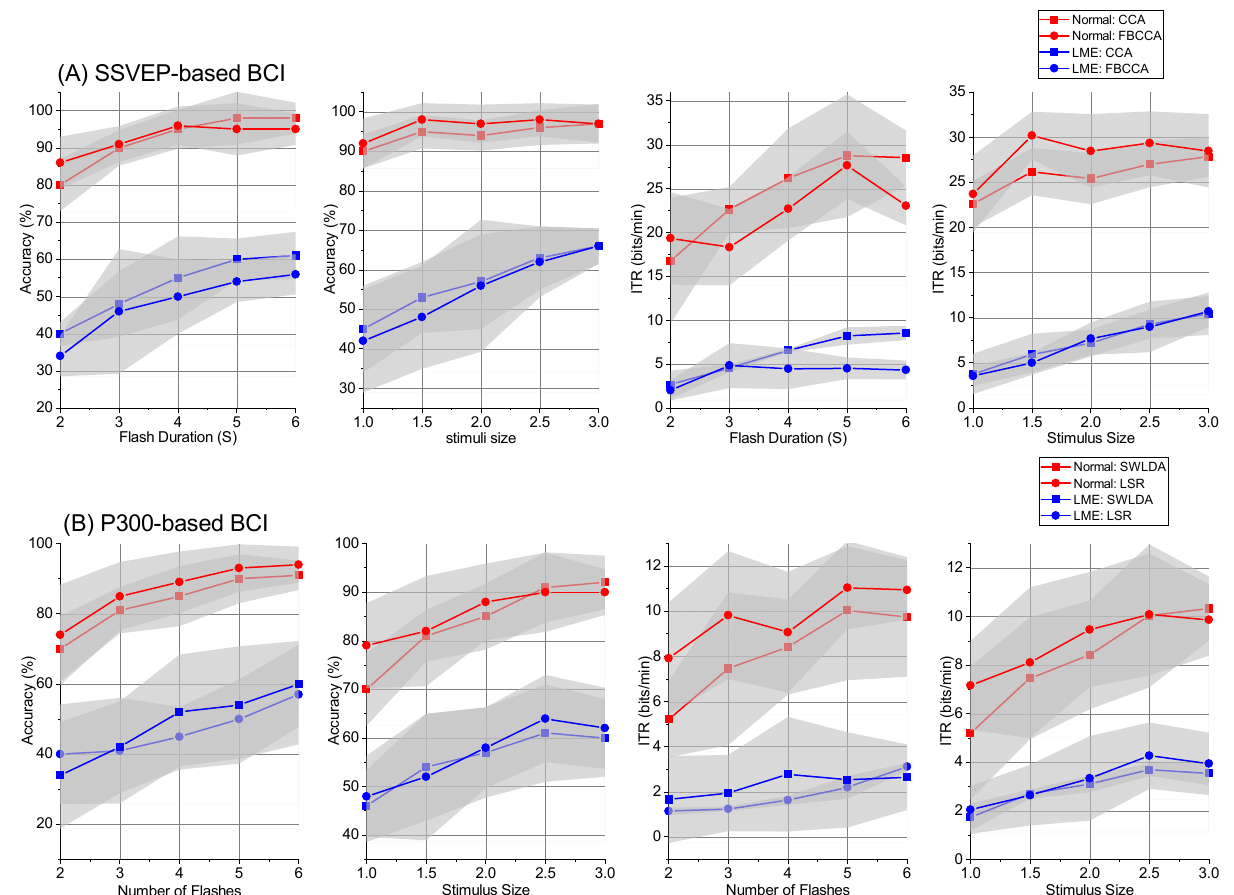
Figure 7. Effects of the flash number, flash duration, and stimulus size on BCI performance. The shaded areas in this figure represent the error bands. We plotted this figure using the EEG signals collected in the optimization phase of the normal and LME condition experiments. The subfigures ( A , B ) showed the experimental results of the P300- and SSVEP-based BCIs, respectively.